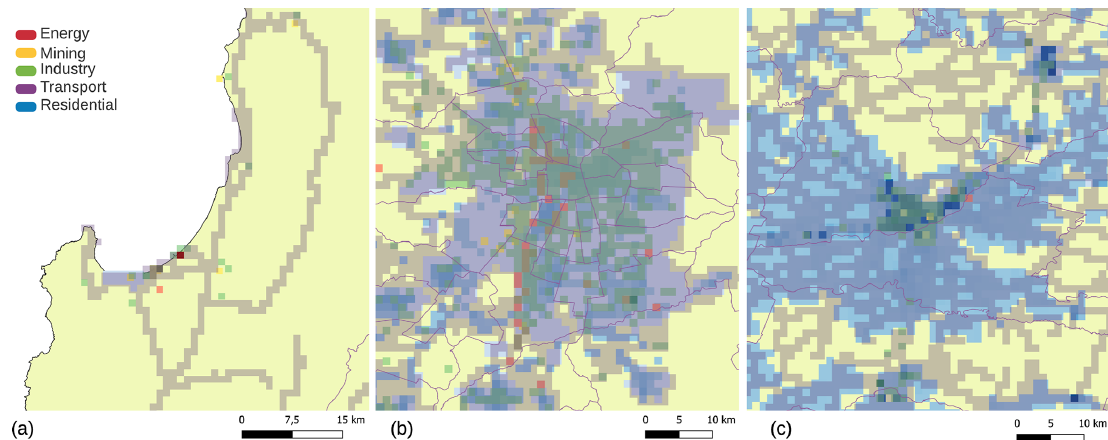
Figure 6. Spatial distribution of the 2017 emissions of PM 2 . 5 from the energy (red), industry (green), residential (blue) and transportation (purple) sectors in a grid of 0 . 01 ◦ × 0 . 01 ◦ (approximately 1km × 1km) for the cities of Mejillones (a) , Santiago (b) , and Temuco and Padre Las Casas (c) . These cities are located in the north, central and south zones,